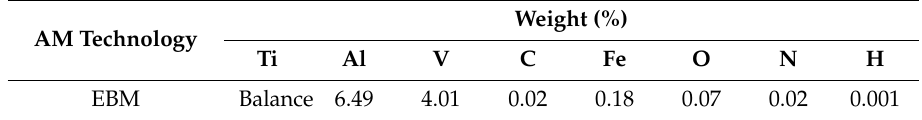
Table 1. Chemical composition of EBM powders according to the specifications of powder producers.